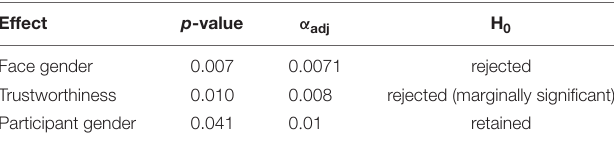
TABLE 3 | The results from the sequential Bonferroni correction of seven different F tests of Experiment 1.